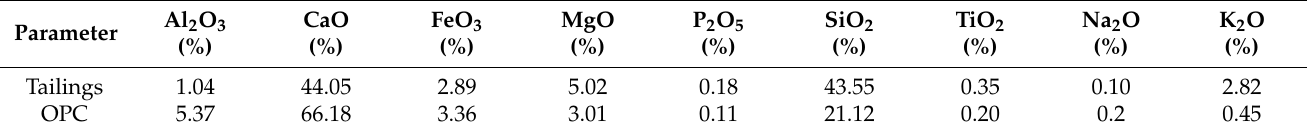
Table 1. Chemical characteristics of the tailings.